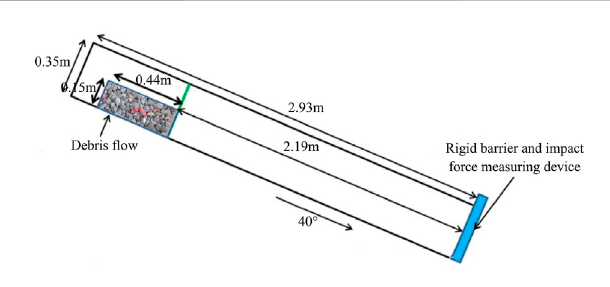
FIGURE 4 Schematic diagram of laboratory test of debris fl ow Jiang et al.